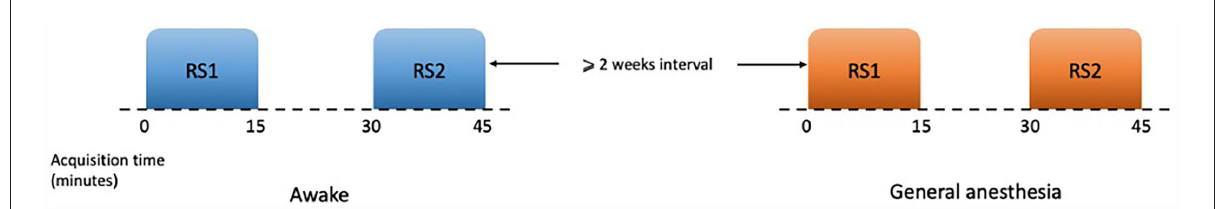
FIGURE1 Schematic of resting-state paradigms. Each session of scan consisted of two sets of rs-fMRI which lasted 15min, and at least 15min gap between them. There was an interval of at least 2 weeks between two sessions of awake and under general anesthesia.